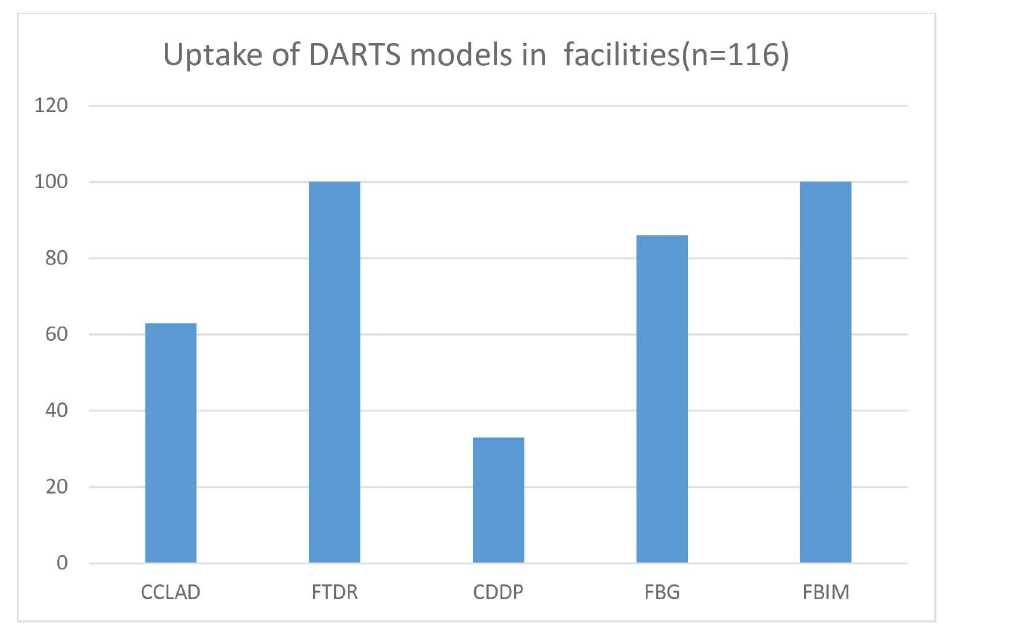
Fig 3. Uptake of differentiated ART delivery